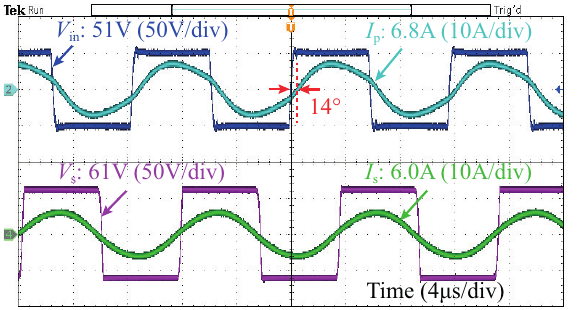
Figure 10. Steady-state experimental waveforms of V in , I p , V s , and I s under the well-aligned condition with R B = 15 Ω